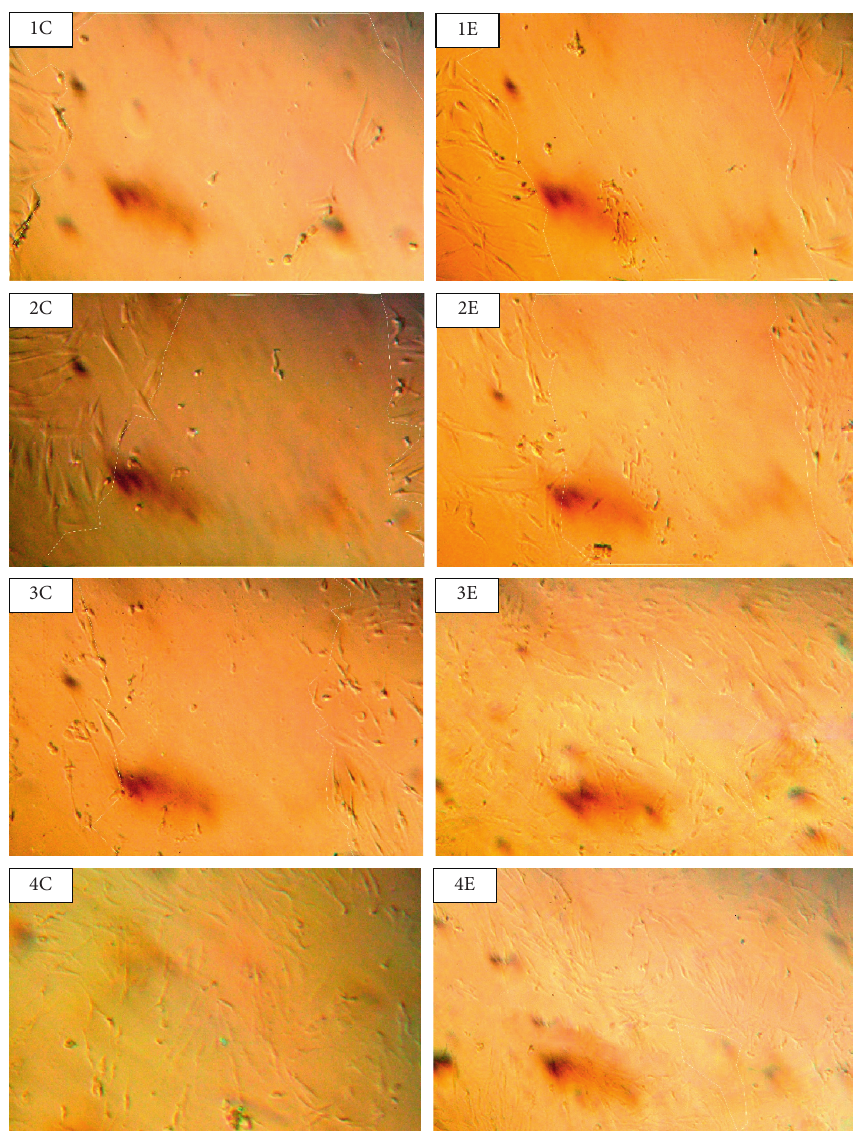
Figure 5: microscopic images (100 × ) of scratch wound healing assay. Pictures 1, 2, 3, and 4, respectively, represent 0, 2, 24, and 48 hours after treatment. (E) is RFF and (C) is control